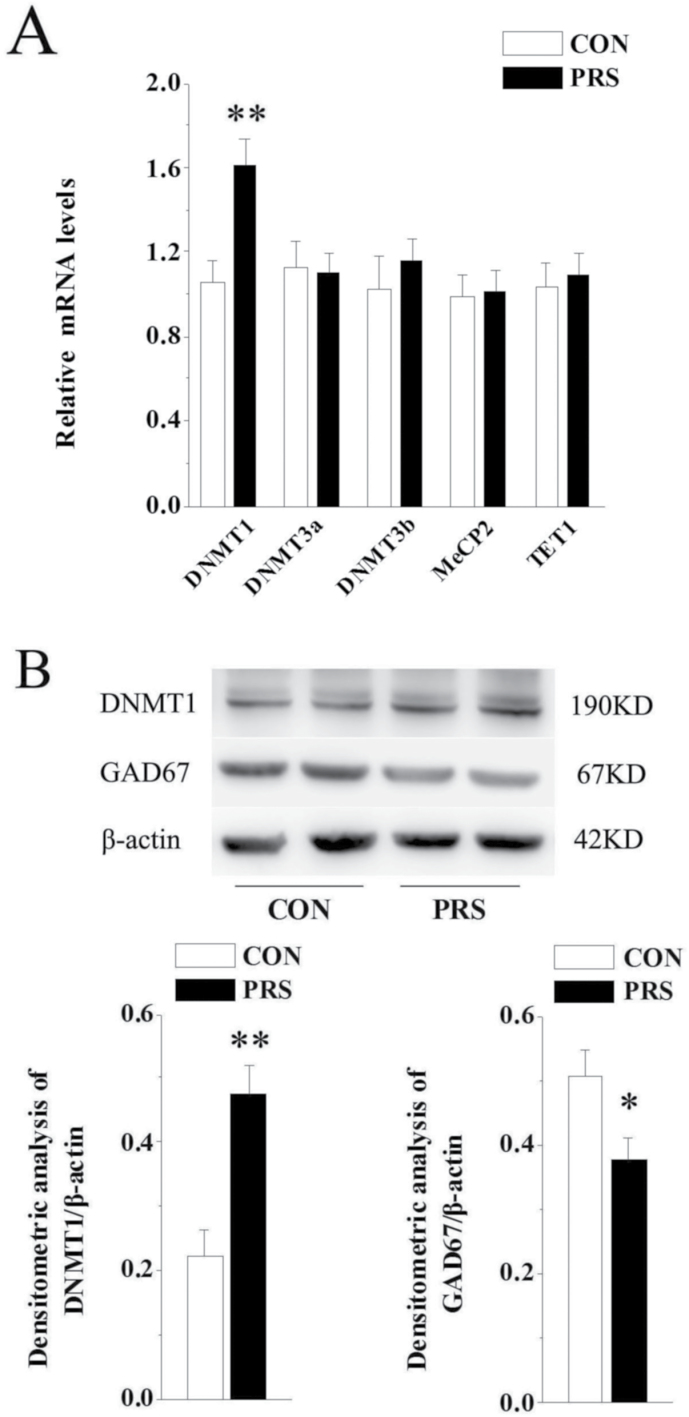
Elevated DNA methyltransferase 1 (DNMT1) levels are accompanied by the decrease of glutamic acid decarboxylase 67 (GAD67) expression in the basolateral amygdala (BLA) of prenatal stress (PRS) mice. CON and PRS represent control and PRS mice, respectively. (A) Quantitative RT-PCR results of DNMT1, DNMT3a, DNMT3b, MeCP2, and TET1 mRNA in the BLA of control and PRS mice. (B) Immunoblot data of DNMT1 and GAD67 normalized by β-actin protein levels. All bars represent means±SEM; 2-tailed Student’s t test; *P<.05 and **P<.01 between the data of control (n=8) and PRS mice (n=8).